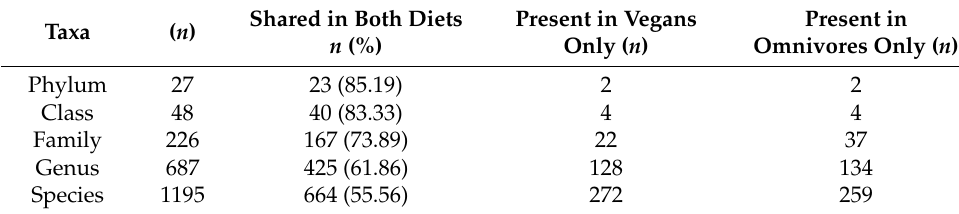
Table 3. Shared and unique taxa of gut microbiota in